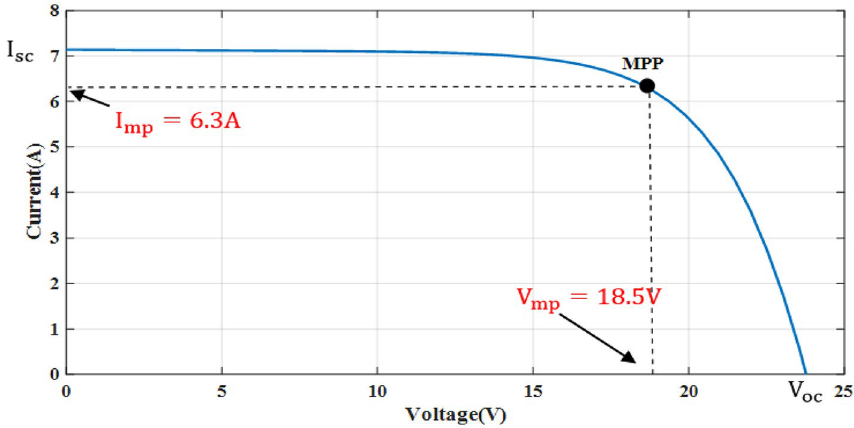
Figure 8. I – V graph of single-diode model at STC.